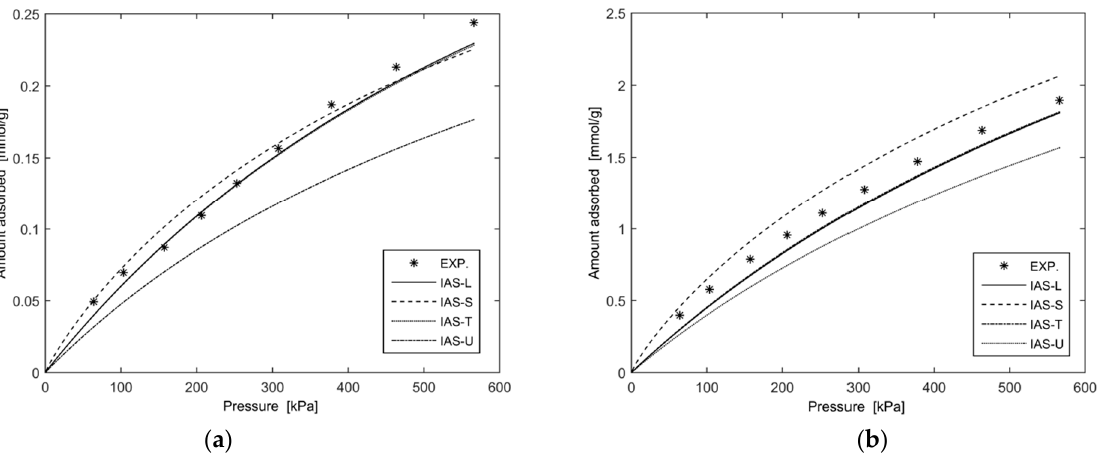
Figure 2. Adsorption results for ( a ) nitrogen and ( b ) methane, as experimentally observed and as obtained with the four implemented models of the IAS theory.